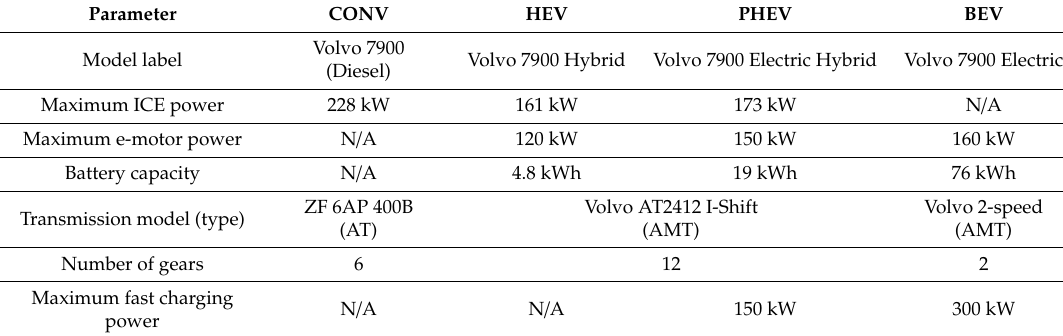
Table 2. Basic parameters of modelled 12 m city buses [19].